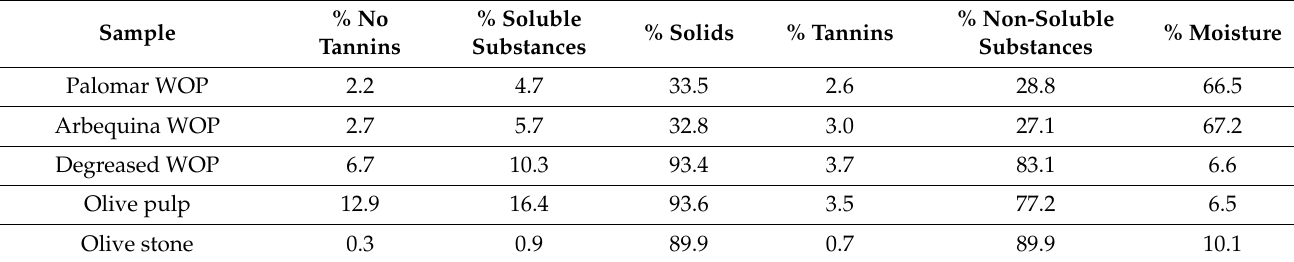
Table 3. Quantification of tannin content of the five fractions of WOP.